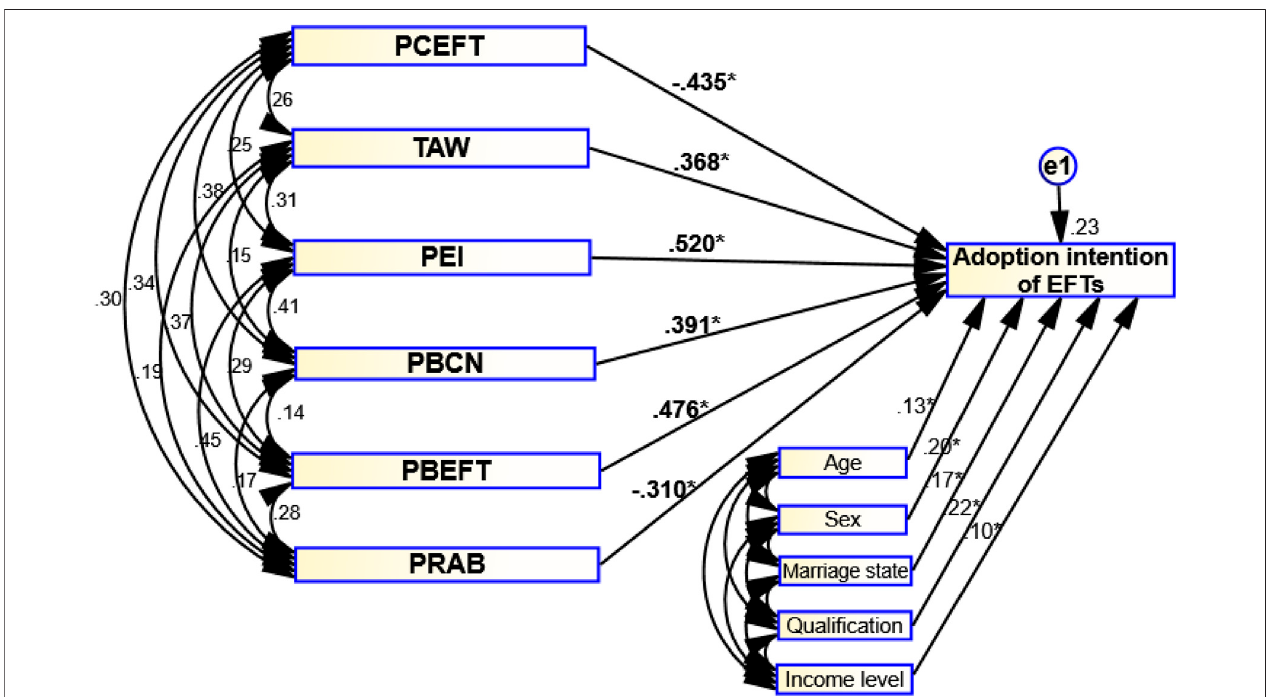
FIGURE 3 | Structural modeling results. Note: * p < 0.05 shows the signi fi cance level at 5%.